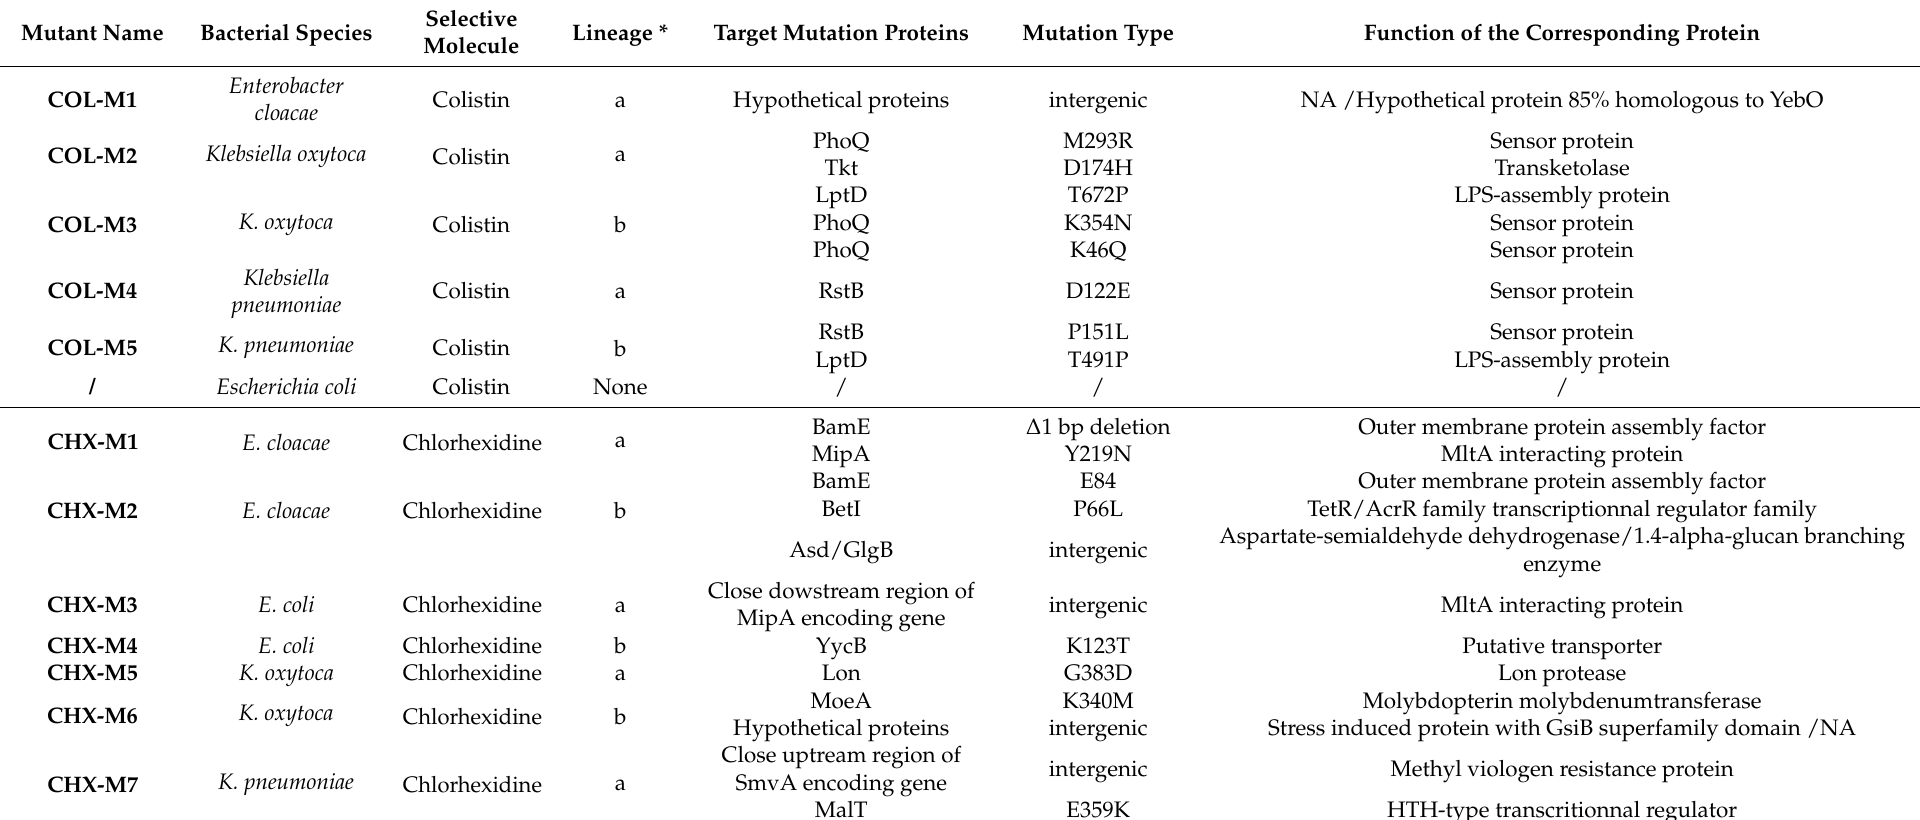
Table 1. Characteristics of the 18 mutants of Klebsiella pneumoniae (KP), K. oxytoca (KO), Enterobacter cloacae and Escherichia coli selected in COL, CHX or OCT media. The mutations in the lineages could be identified after whole ge-nome sequencing that could be obtained and comparison of each lineage genomic sequence with its ancestor using breseq (30). Proteins targeted by the mutation, and associated function are indicated. In brackets correspond the range of MIC in-creased, expressed in fold, by comparison to the parental